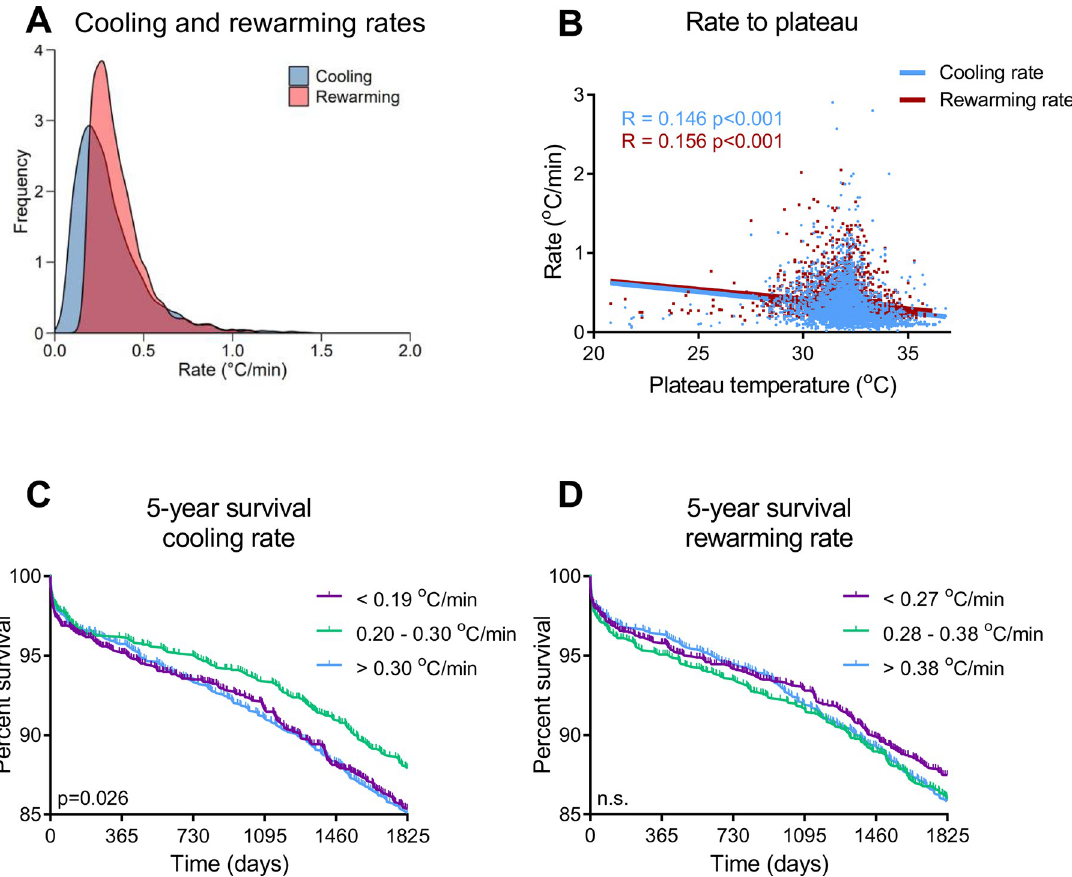
Fig 4. Survival relative to cooling and rewarming rate. (a) Density plot of the cooling and rewarming rates. (b) Scatterplot cooling and rewarming rates with plateau temperature (c) Cooling rate– 5-year survival (d) Rewarming rate– 5-year survival.